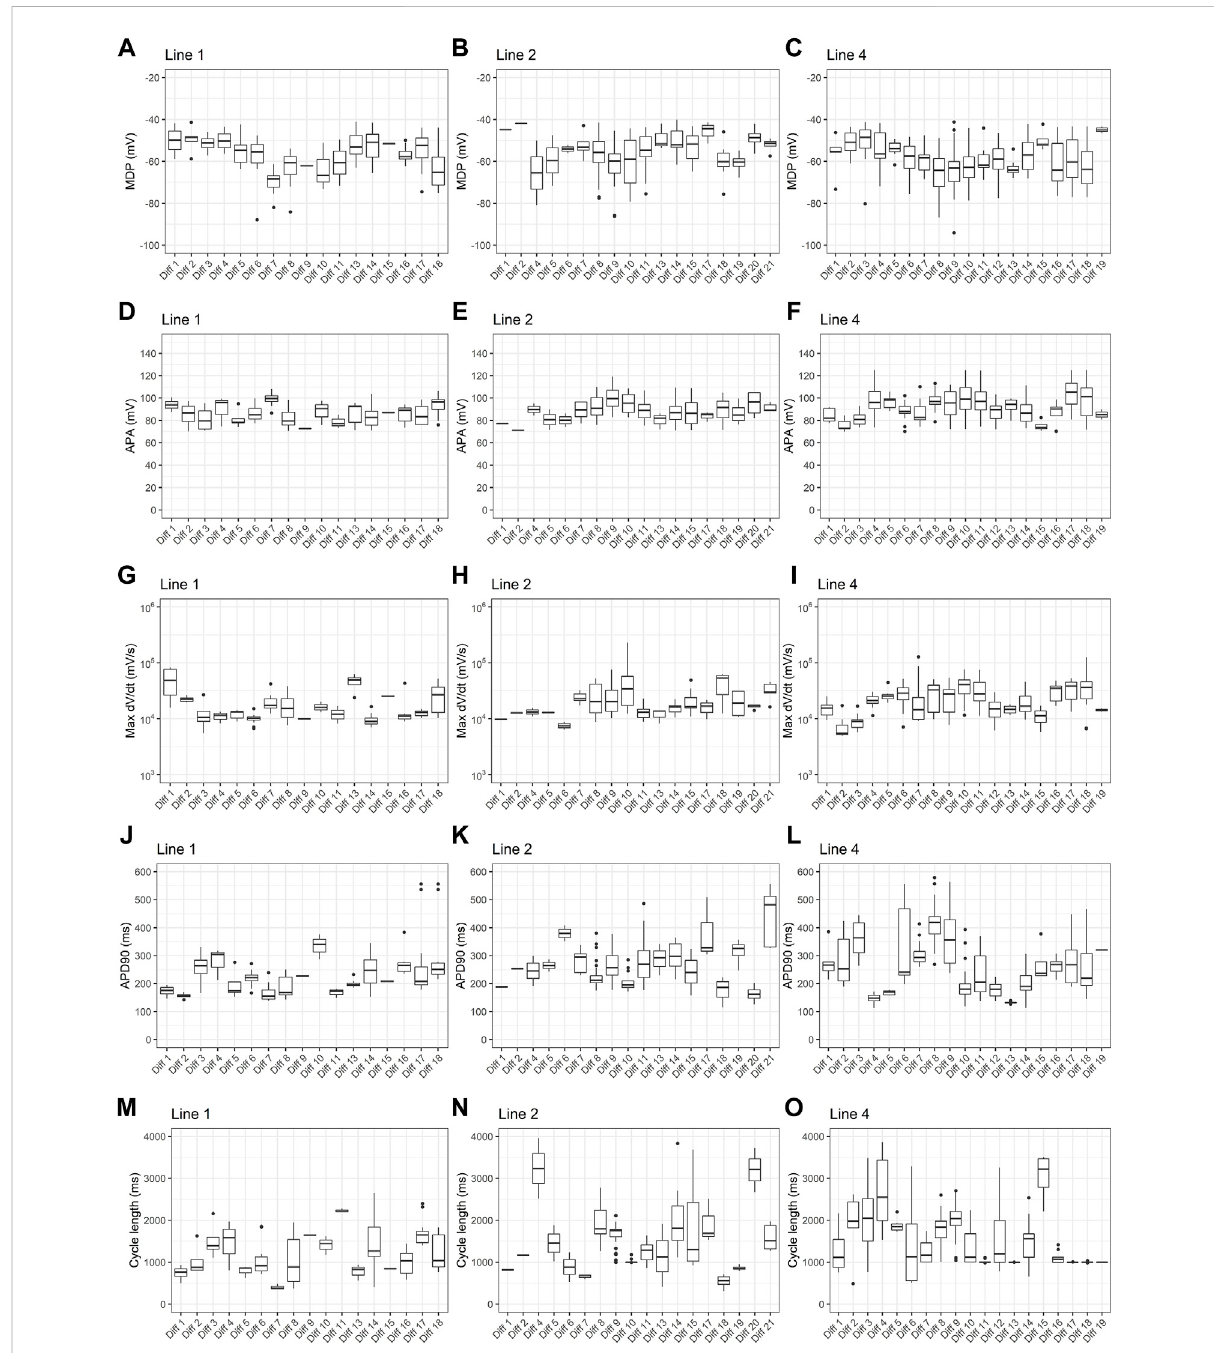
Effectofdifferentiationbatchonactionpotentialparameters.Boxplotsof (A – C) maximumdiastolicpotentials(MDP), (D – F) actionpotentialamplitudes (APA), (G – I) maximumdV/dt(dV/dtmax), (J – L) actionpotentialdurationat90%repolarization(APD90)and (M – O) cyclelengthareshownforthreedifferent cell lines. For line 1, all batches used Kattman ’ s differentiation protocol. For lines 2 and 4, Lian ’ s protocol was used for all